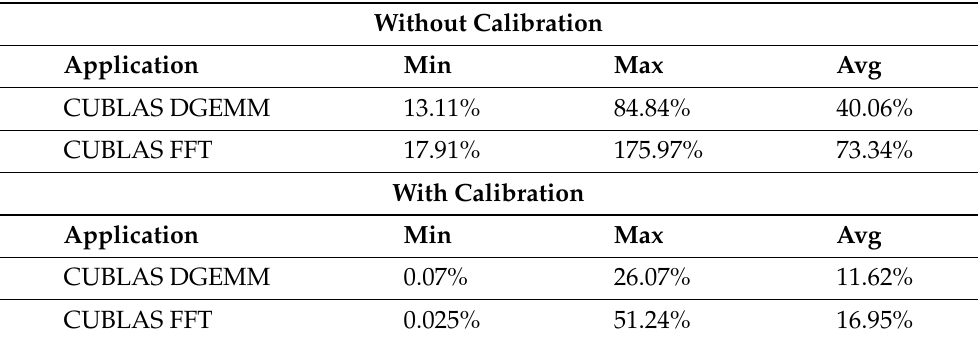
Table A4. Percentage error of dynamic energy consumption obtained using NVML against the ground truth on Nvidia P100 PCIe GPU (Figure 1) with and without